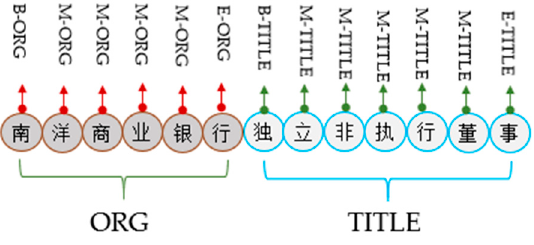
Figure 2. Named-entity annotation results for ResumeNER.